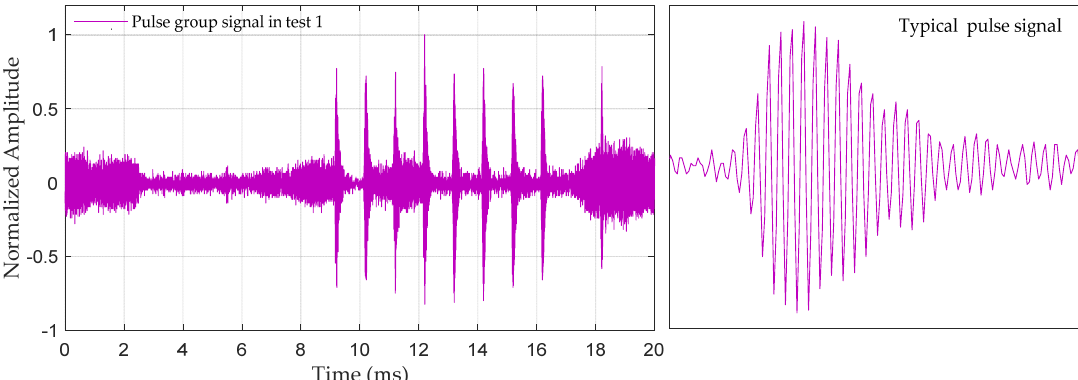
Figure 12. eLoran signal collected in Test 1.